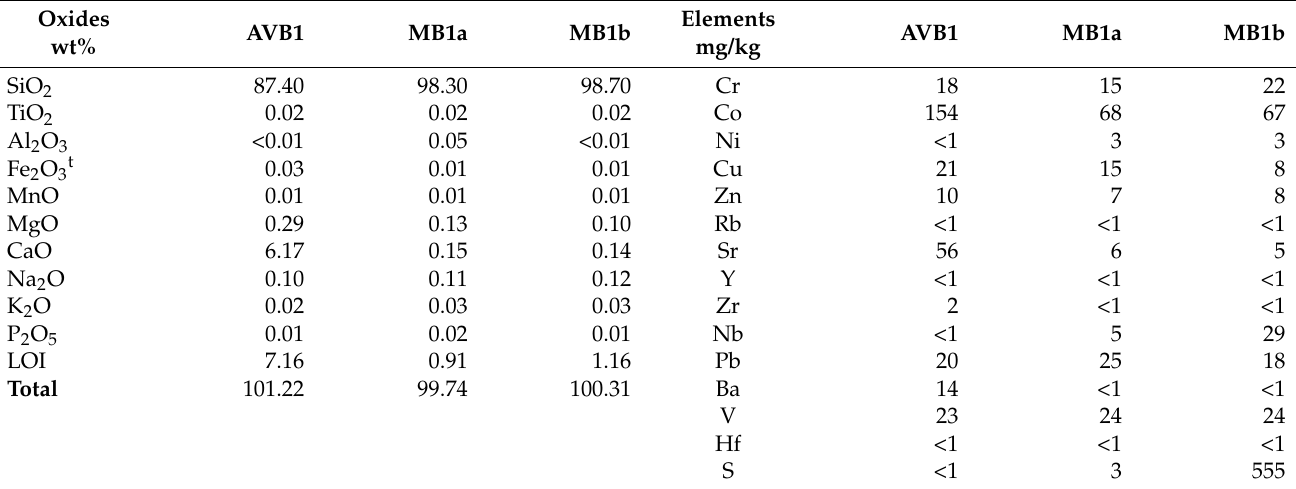
Table 3. Representative chemical analyses of the studied